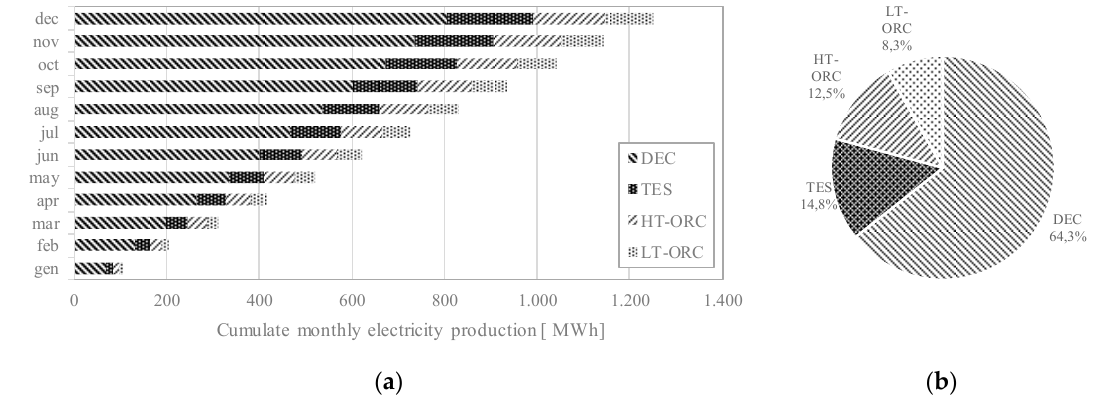
Figure 8. Cumulate monthly electricity production for each plant section ( a ) and percentage annual distribution ( b ).